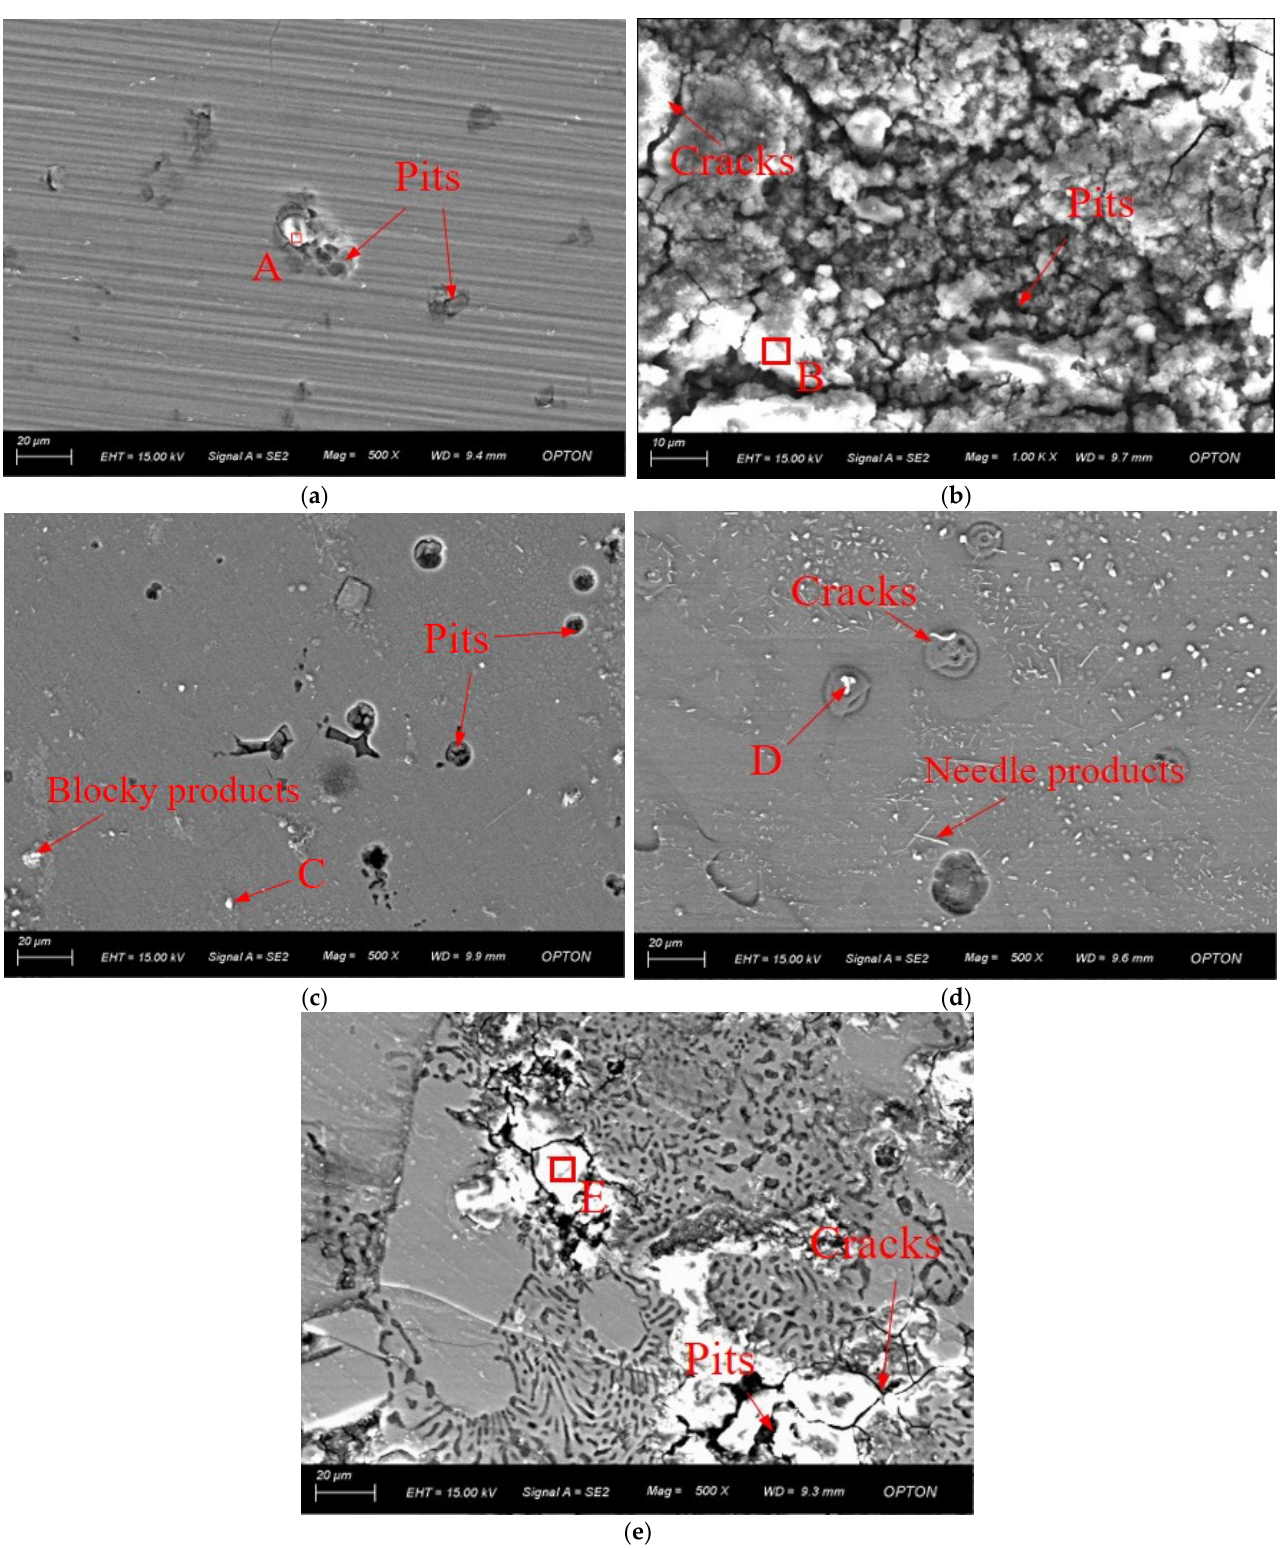
Figure 8. Surface morphologies of the substrates and different diffusion layers after potentiodynamic electrochemical measurements: ( a ) Al1060, ( b ) Mg1, ( c ) Mg 2 Al 3 layer, ( d ) Mg 17 Al 12 layer, and ( e ) Mg 17 Al 12 and Mg-based solid solution layer.